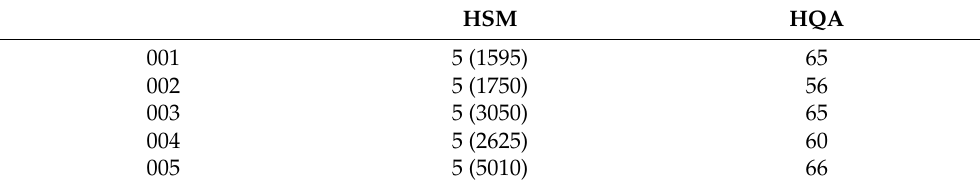
Table 9. Results obtained in the HQA and HMS indices for the transects analyzed.